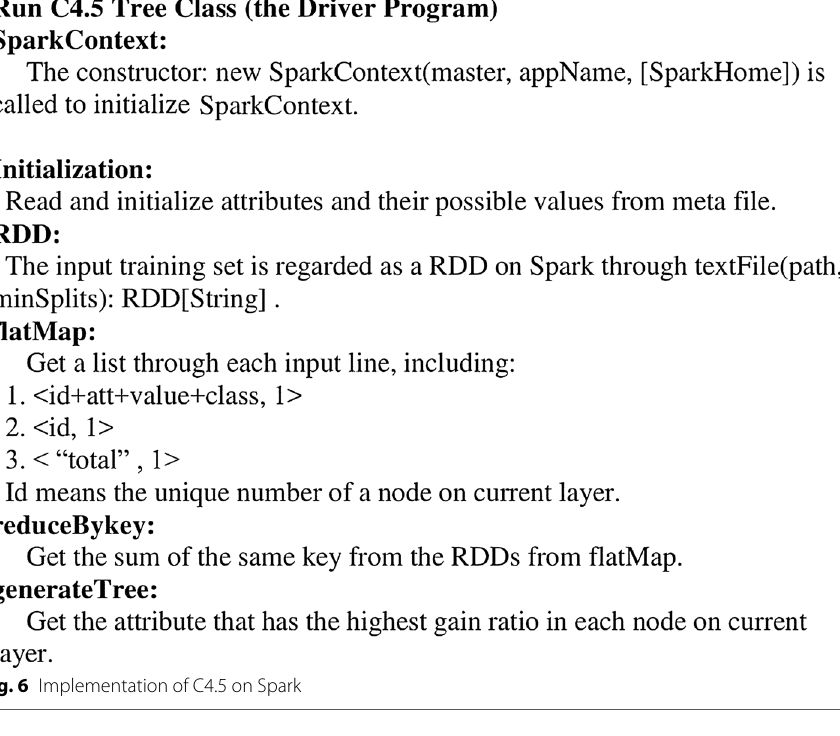
Fig. 6 Implementation of C4.5 on